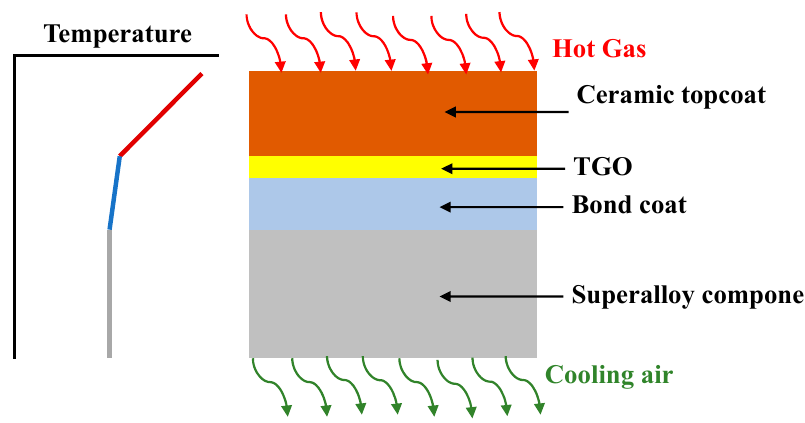
Figure 7. Schematic of the coating structure in the SX turbine blades (Adapted from [40]).